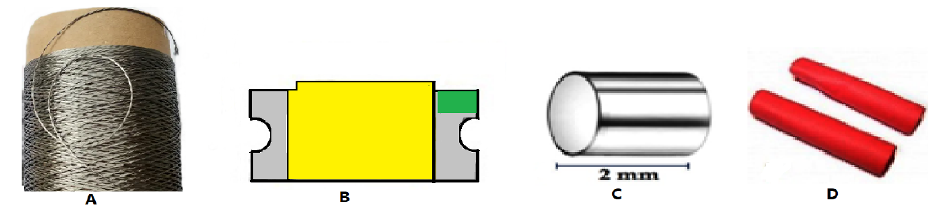
Figure 1. Image of stainless steel conductive yarn ( A ), SMD LED components ( B ), silver crimp beads ( C ), and heat shrink tube ( D ).